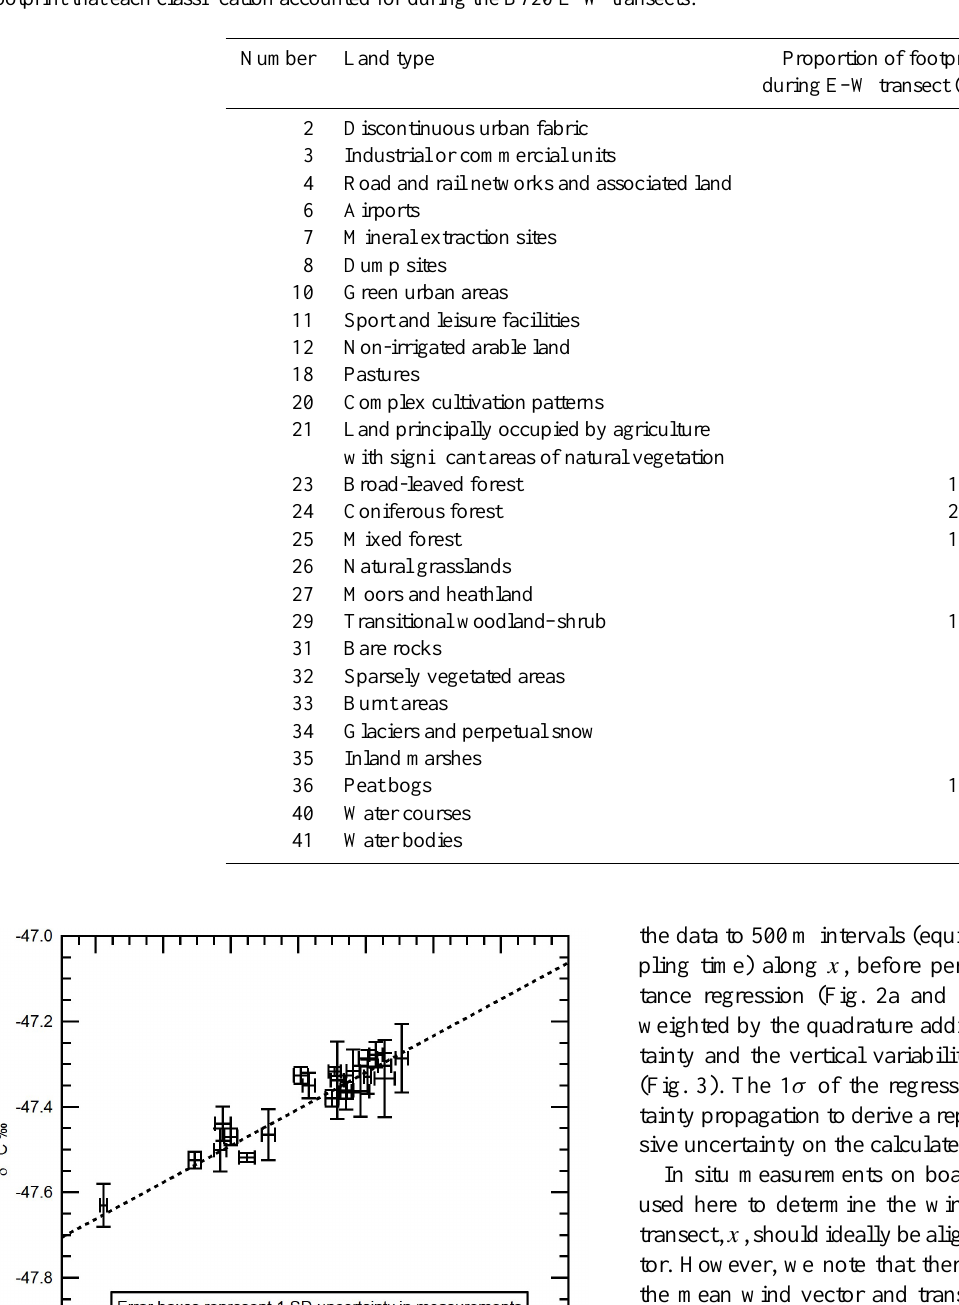
Table 1. Land classification key corresponding to Fig. 1c from CORINE land cover 2006. Also included is the proportion of the aircraft’s footprint that each classification accounted for during the B720 E–W transects.